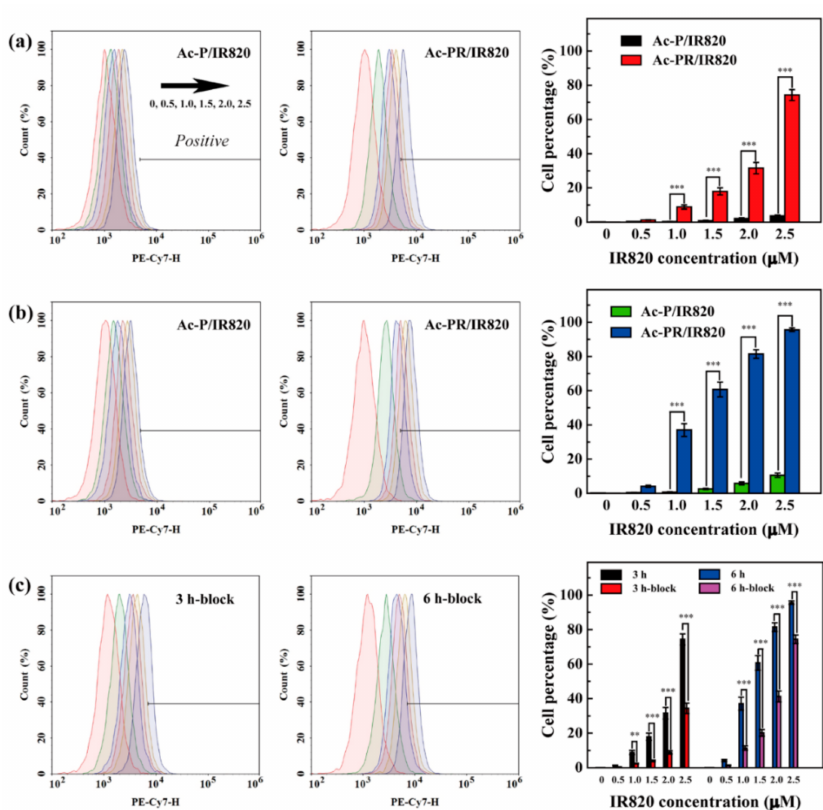
Figure 6. Flow cytometry analysis of U87MG cells after co-incubation with Ac-P/IR820 and Ac-PR/IR820 dendrimers for 3 h ( a ) and 6 h ( b ). U87MG cells pre-incubated with free RGD (2 µ M) for 3 h and then co-incubated with Ac-PR/IR820 dendrimers for 3 h and 6 h were also tested for comparison ( c ) (* for p < 0.05, ** for p < 0.01, and *** for p < 0.001, respectively).